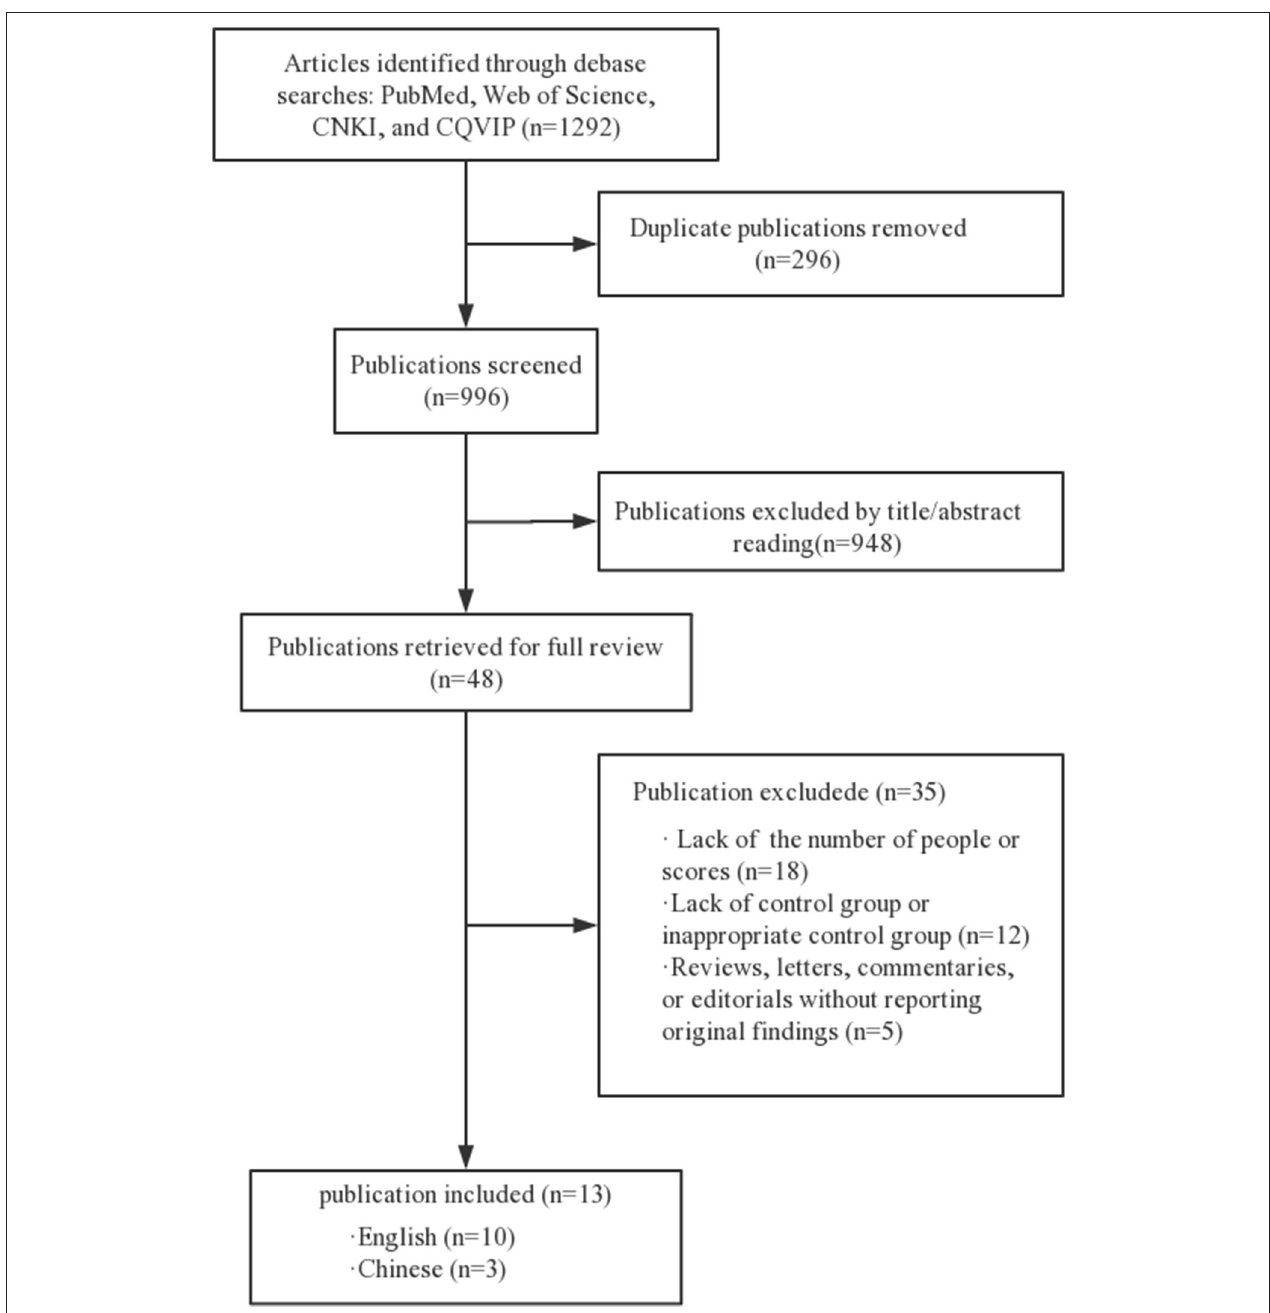
FIGURE 1 | Selection process for study inclusion in the systematic review and